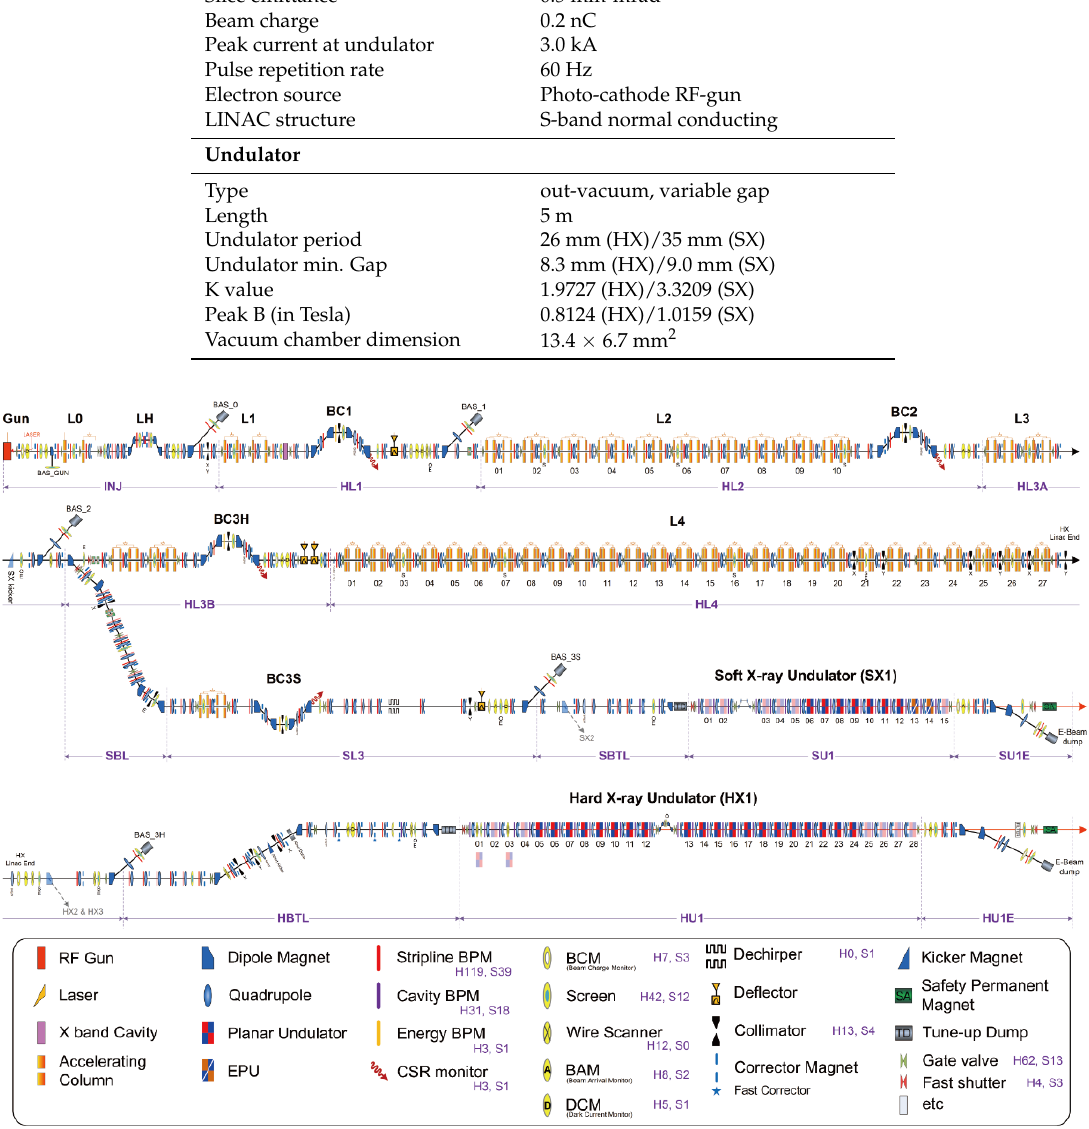
Figure 2. Schematic layout of PAL ‐ XFEL.